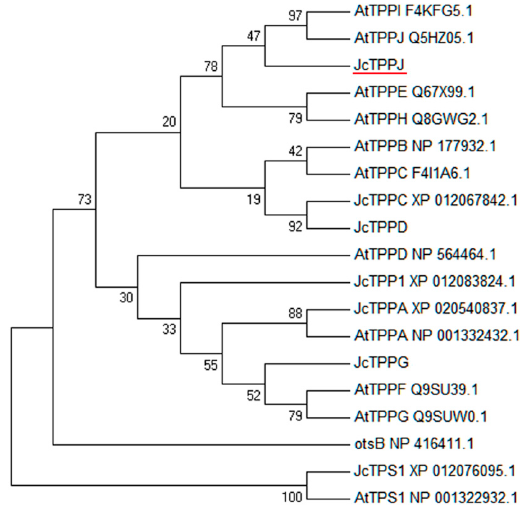
Figure 1. Phylogenetic analysis of TPP family members in Jatropha , Arabidopsis , and bacterium, and the amino acid sequences of JcTPS1 and AtTPS1 were used as outgroups. The tree was constructed by the neighbor-joining (N-J) method. The GenBank accession numbers are listed in Table